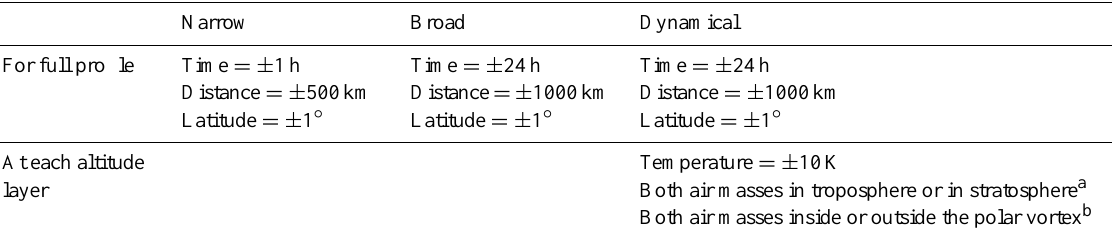
Table 1. Coincidence criteria for SAGE II and OSIRIS comparisons.